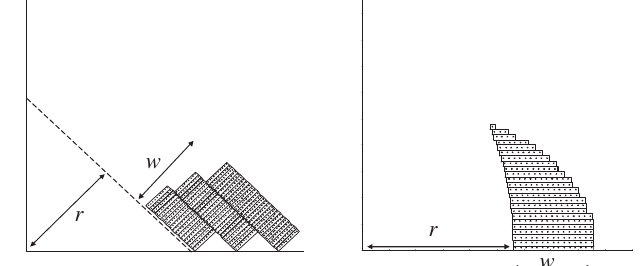
FIG. 18. The racetrack (left) and the intersecting ellipses (right) coil layouts (one eight of the whole cross section shown in the plot).